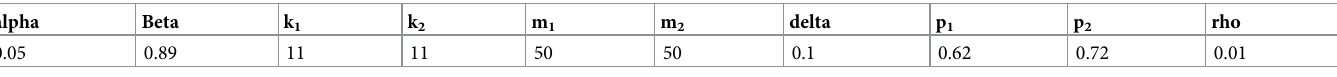
Table 2. Power and sample size for the comparison of service delivery model for the SHeS’Cap-Linkage study in uMgungundlovu district, KwaZulu-Natal, South Africa,